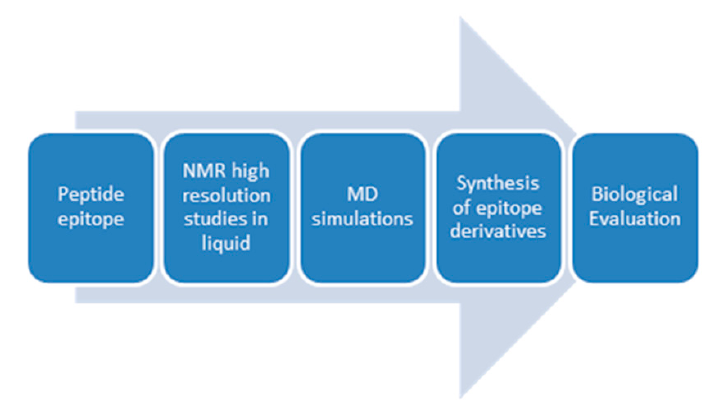
Figure 2. Steps of a rational design process aiming to aid the development of peptide mimics against multiple sclerosis (MS).